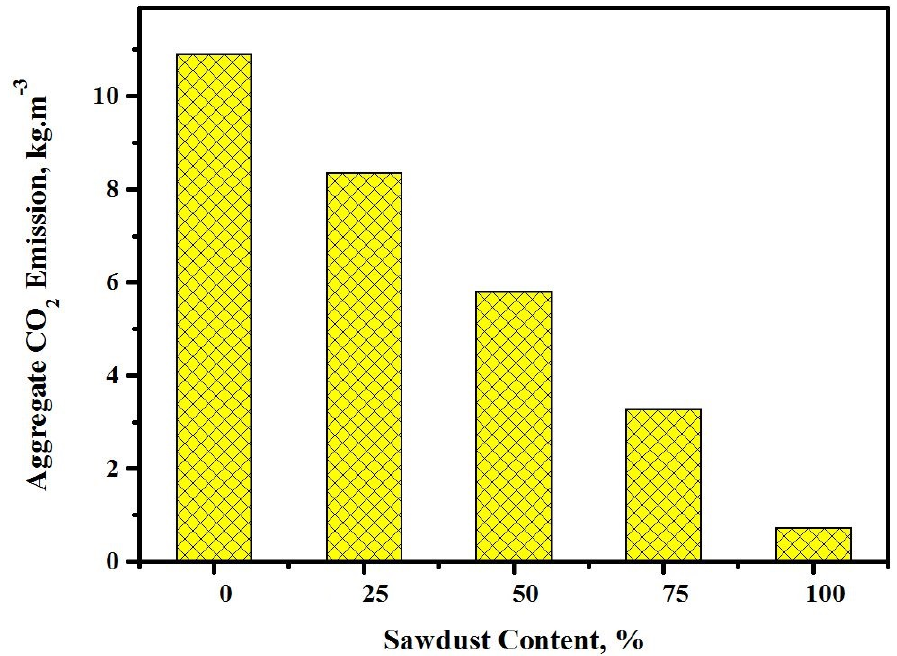
Figure 22. E ff ect of the sawdust content on the prepared concrete aggregate carbon dioxide Figure 22. Effect of the sawdust content on the prepared concrete aggregate carbon dioxide emission.